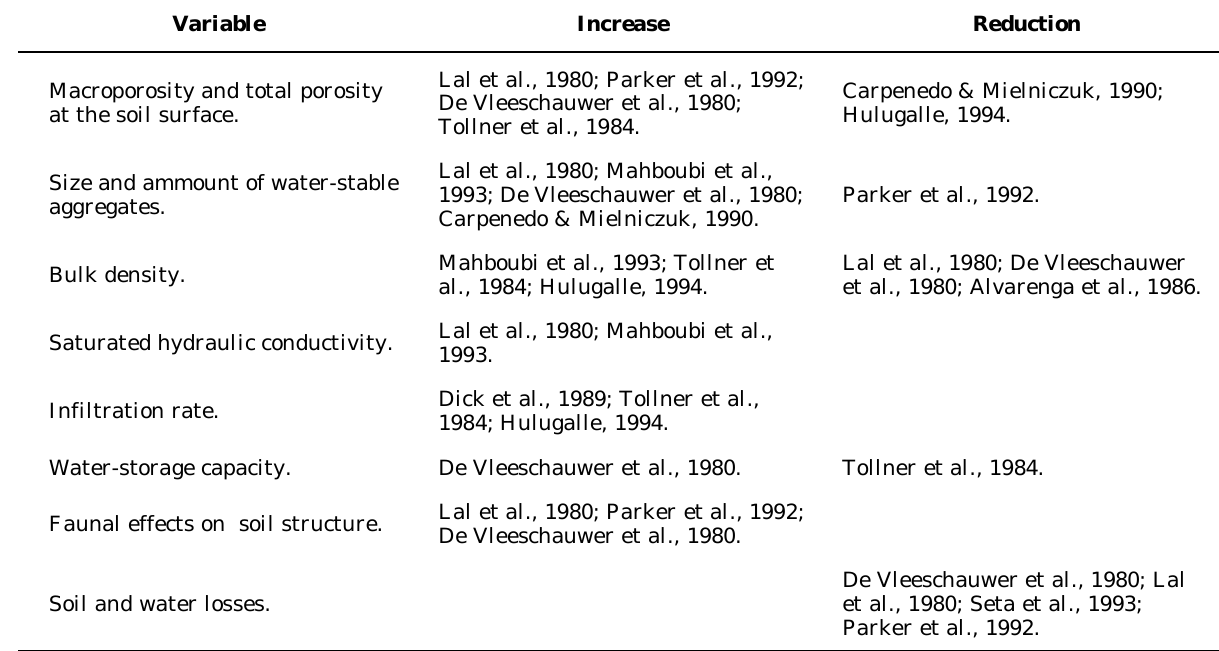
Table 1. Experimental results of the effects of no-tillage and associated practices of management, reported in the literature